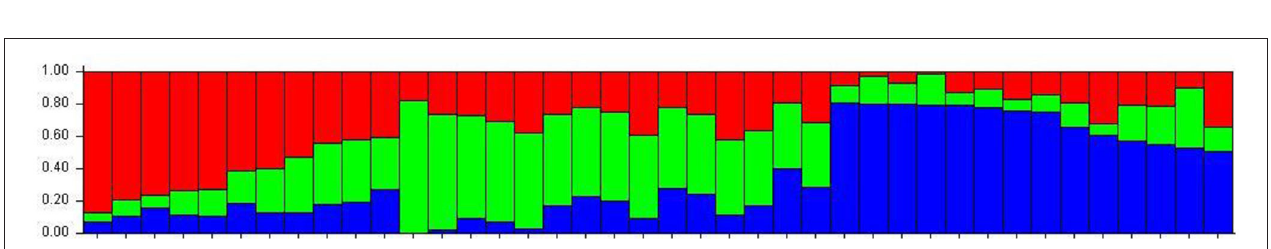
FIGURE 6 | (A) Delta K graph obtained by structure Harvester software, a derivative of the mean log-likelihood function of Delta K, showing the highest value of delta K at K=3, which indicated that the entire population of T. indica in India can be divided into three sub-population (B) The mean log-likelihood of the number of populations (K) run on a set of potential K values (1–10) and assessed through longer Markov chain Monte Carlo (MCMC) generations.